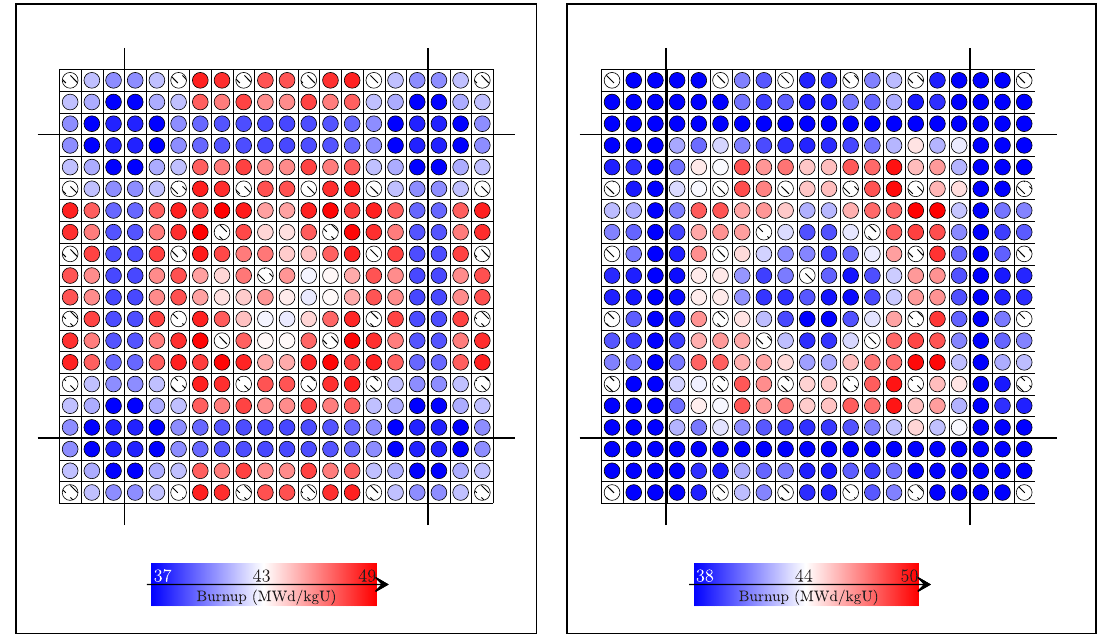
Fig. 3. Rod burnup distributions for the assembly M109 (and neighbors) and segment 6 containing the BM1 and BM3 samples at the EOC for cycle 22. Left: CASMO5 values; right: SIMULATE–3